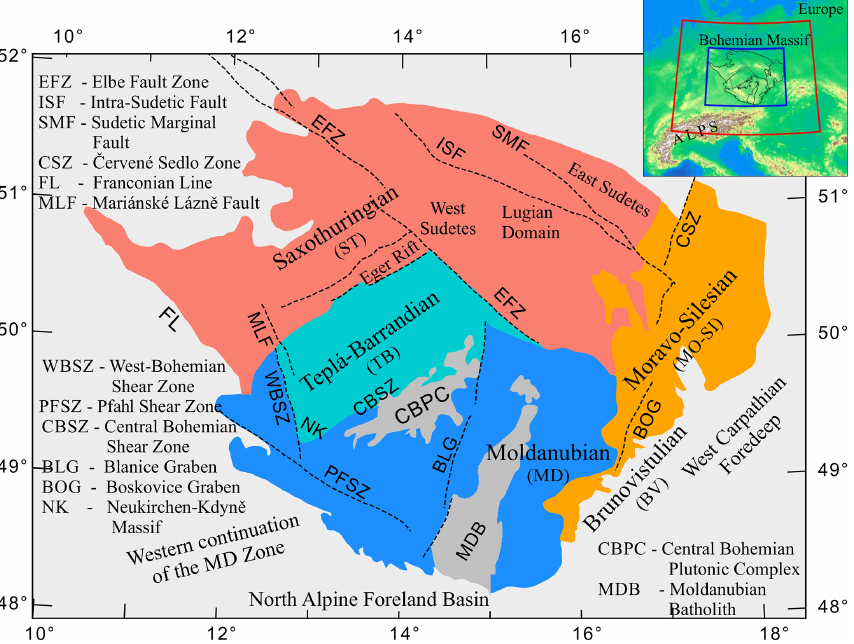
Figure 1. Simplified overview of tectonic units of the Bohemian Massif (BM) and fault systems. The modelled region is framed in blue in the inset, and the red frame denotes the area of seismic stations used in the